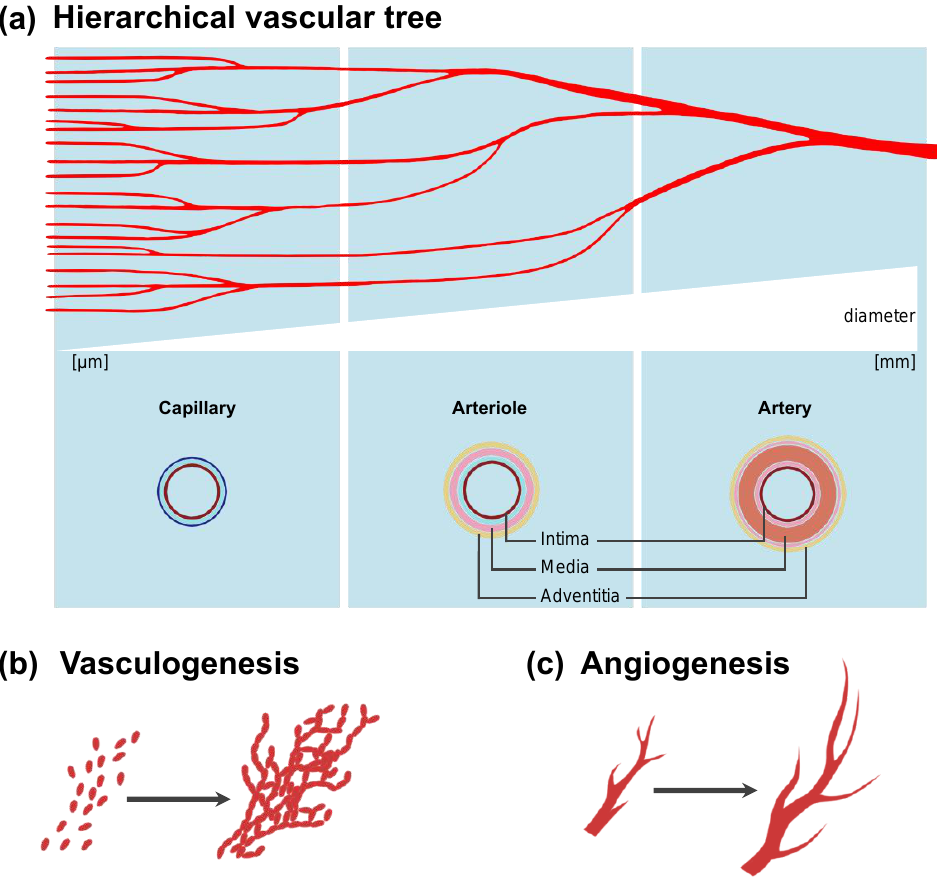
Figure 2. Overview of hierarchical vascular tree and vascular development mechanisms. ( a ) Partial representation of arterial vascular tree with dichotomous branching. Arteries and their smaller downstream branches, the arterioles, present a layered wall structure. Generally, the media containing smooth muscle cells is more pronounced in arterial vessels. Via the arterioles, blood is transported into the capillary bed, capable of gas and nutrient exchange. Capillaries consist of a single endothelial layer enabling permeability. ( b ) The mechanism of vasculogenesis describes the formation of a primitive vascular network by endothelial progenitor cells, usually during embryogenesis. ( c ) Angiogenesis describes a growth of vessels from the existing vasculature, e.g., by sprouting. Angiogenesis can be a physiological or pathological process.